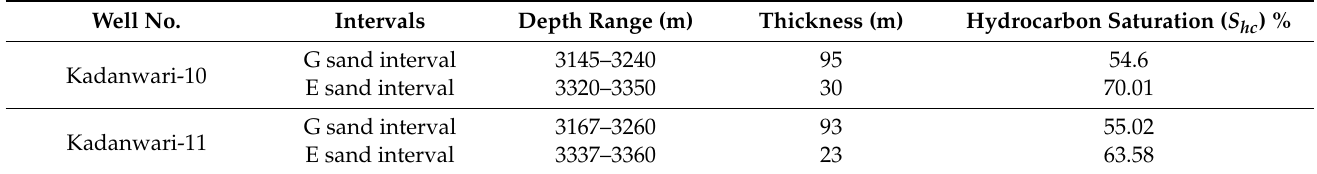
Table 5. Depth range, thickness, and S hc (%) of the Cretaceous G and E sand intervals in Kadanwari-10 and 11 wells.